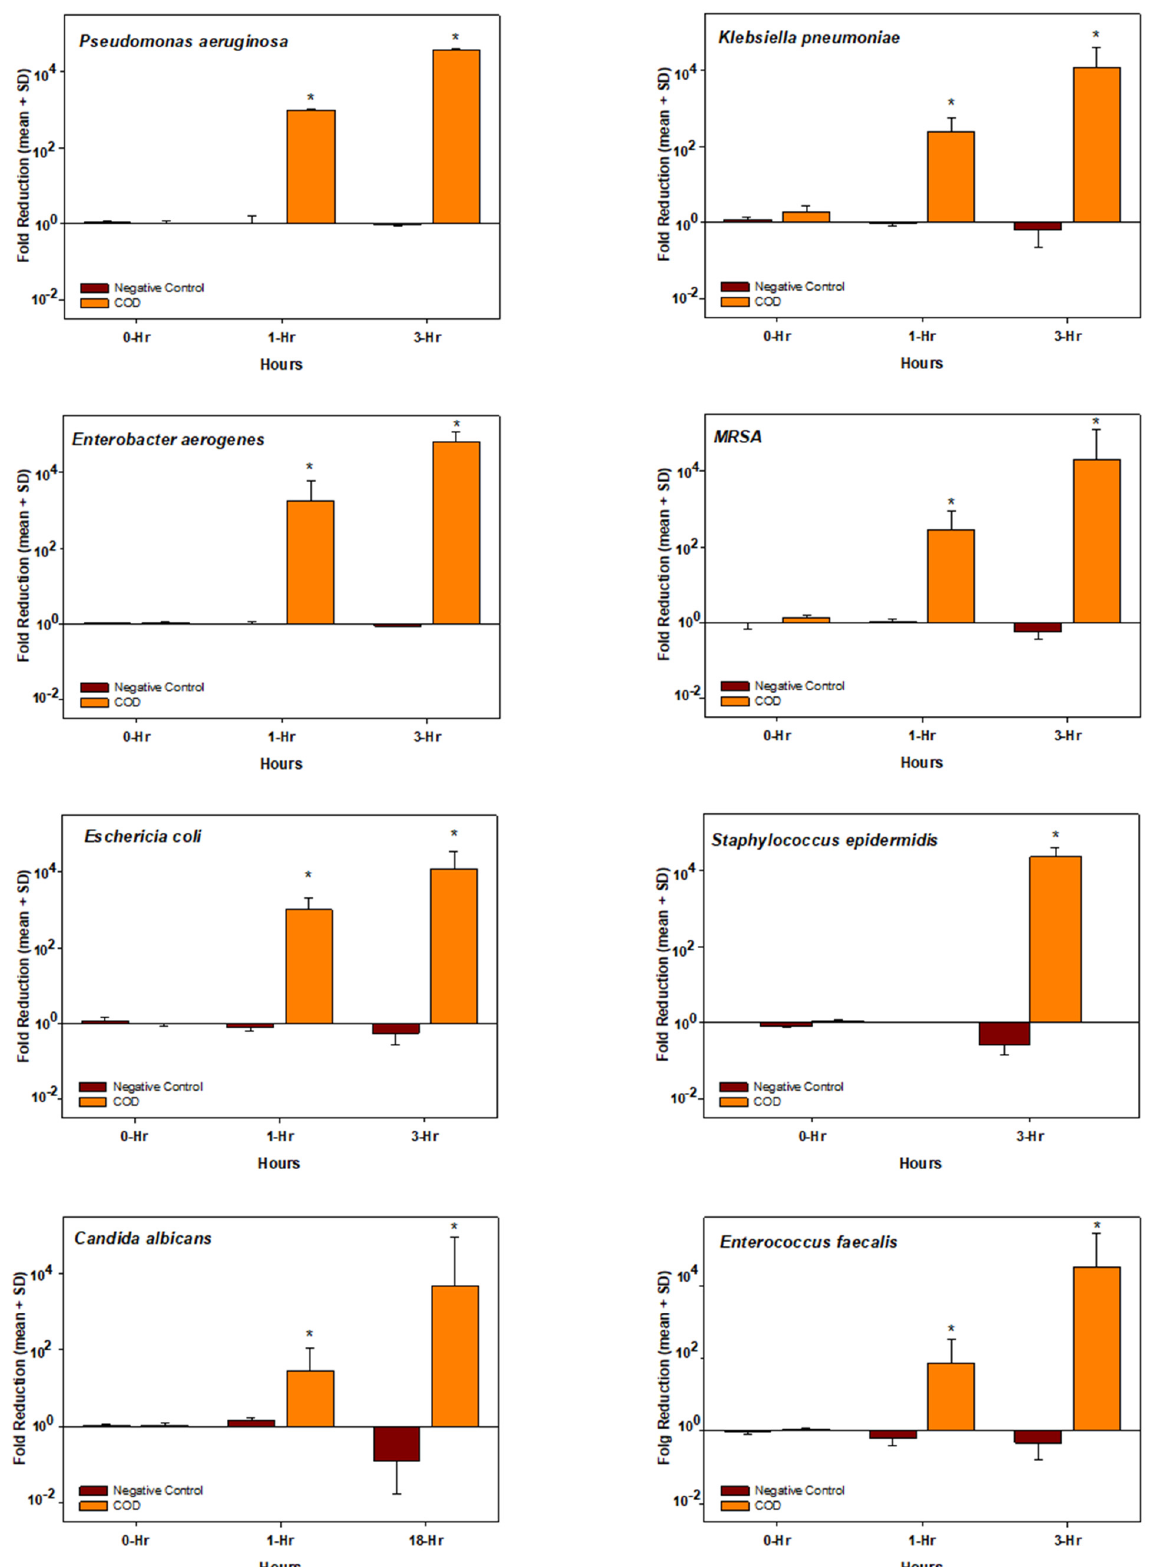
Figure 2. Biocidal efficacy of the COD. Each graph shows the mean ± SD fold reduction of at least duplicate experiments per each microorganism tested and per each incubation period. The statistical differences between the microbial titers obtained at each time point between the COD and the negative control dressing were examined by t -tests. * = p <